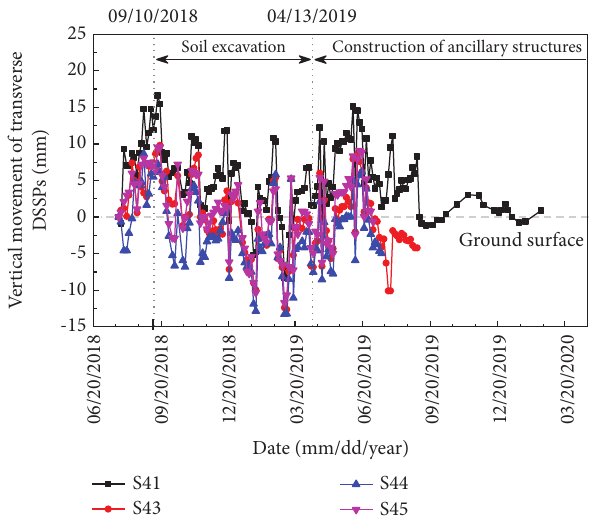
Figure 9: Development of the vertical movements of the transverse DSSPs.